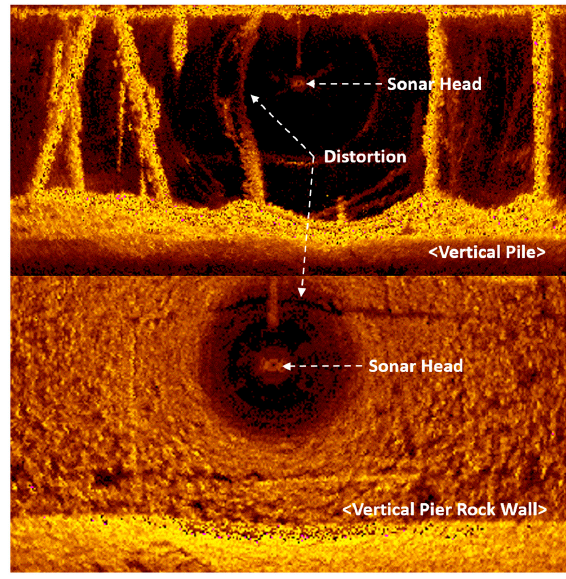
Figure 6. Slant range distortion.